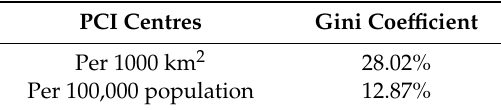
Table 4. Gini coe ffi cient in